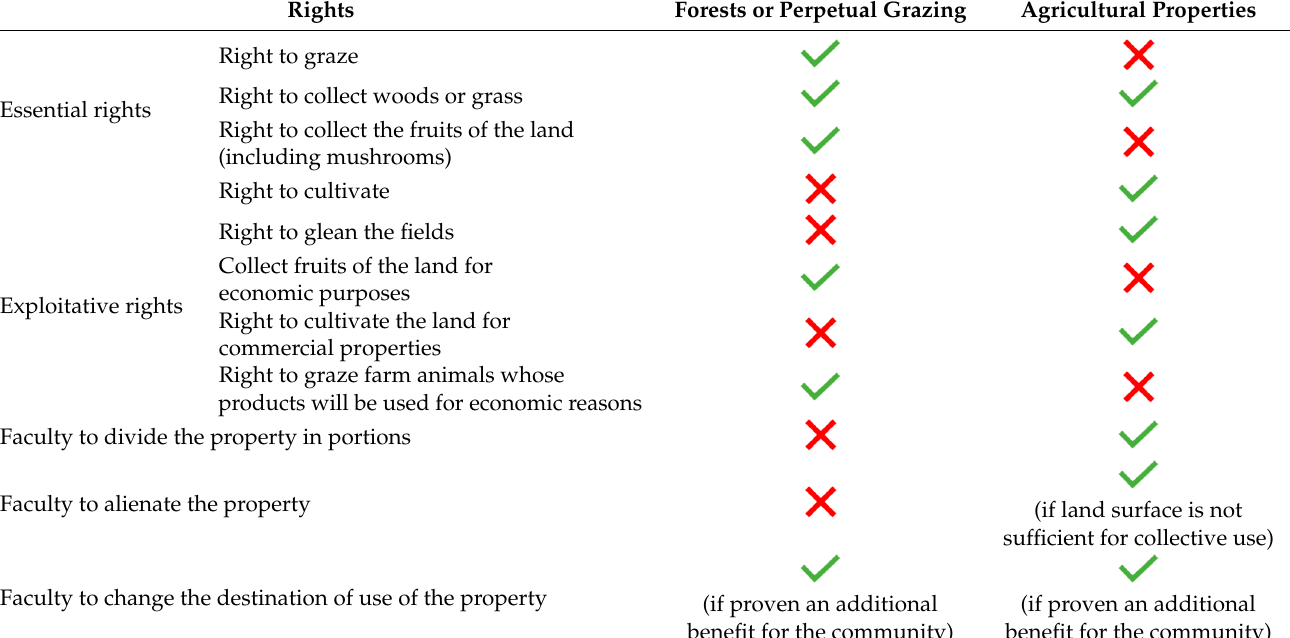
Table 1. Table summarising the main rights and faculties connected to civic use